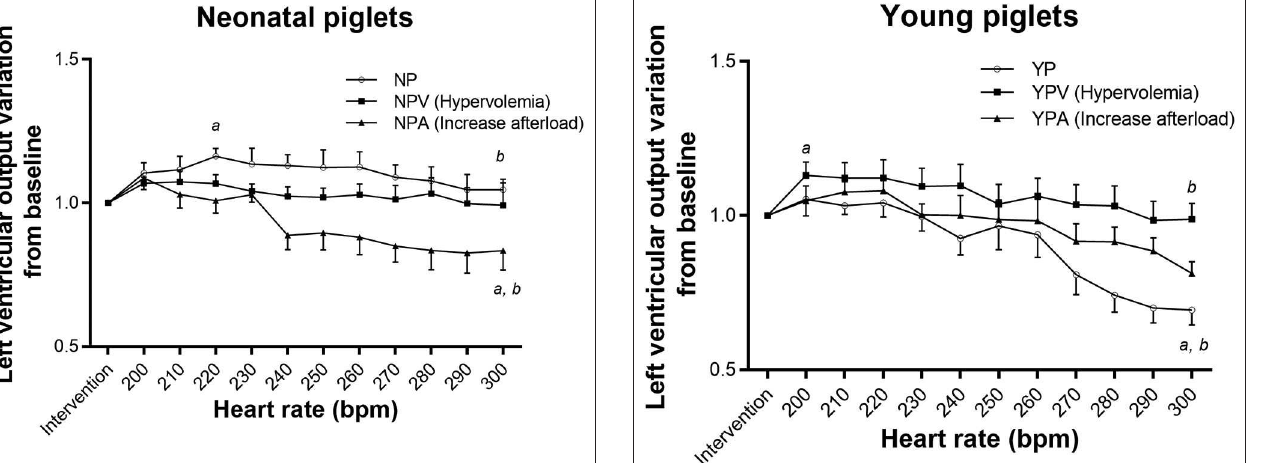
FIGURE 1 | Tolerance to tachycardia in neonatal groups. In NP and NPA (increase afterload) groups, left ventricular output varied with pacing. It slightly increased with pacing for NP. Left ventricular output decreased significantly at faster heart rates in NPA. In group NPV (hypervolemia), pacing had no effect on LVO. a Different from post-intervention value ( p < 0.05). b Different from maximum value reached ( p < 0.05).